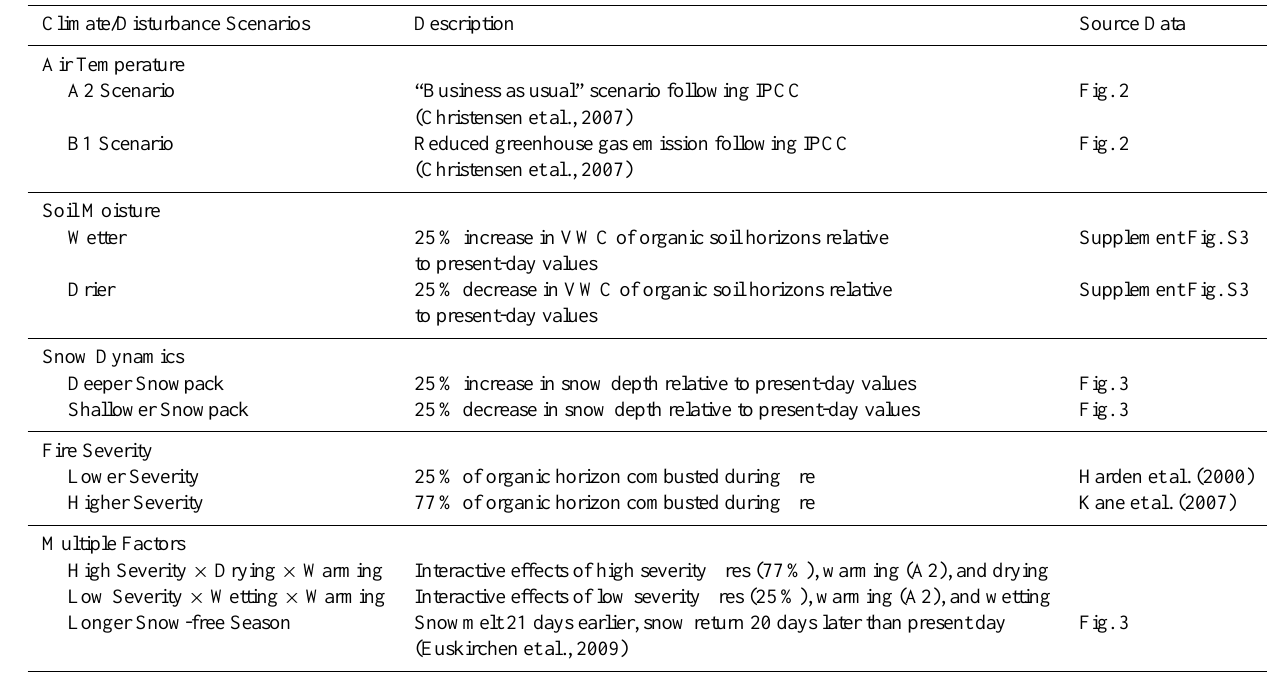
Table 1. Climate and disturbance scenarios tested using GIPL and Fire-C